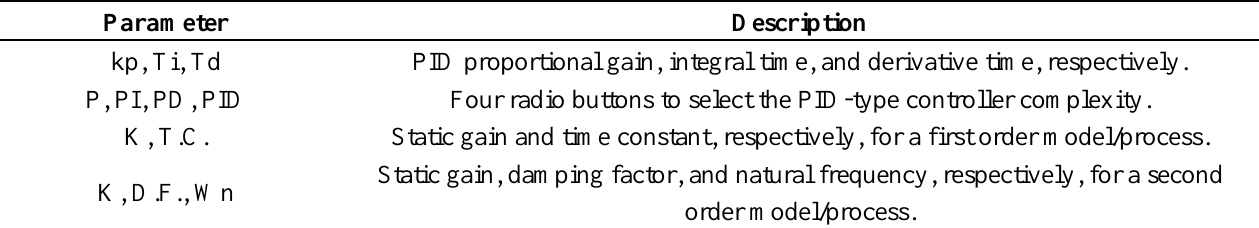
Table 1. Parameters available in the interactive simulation